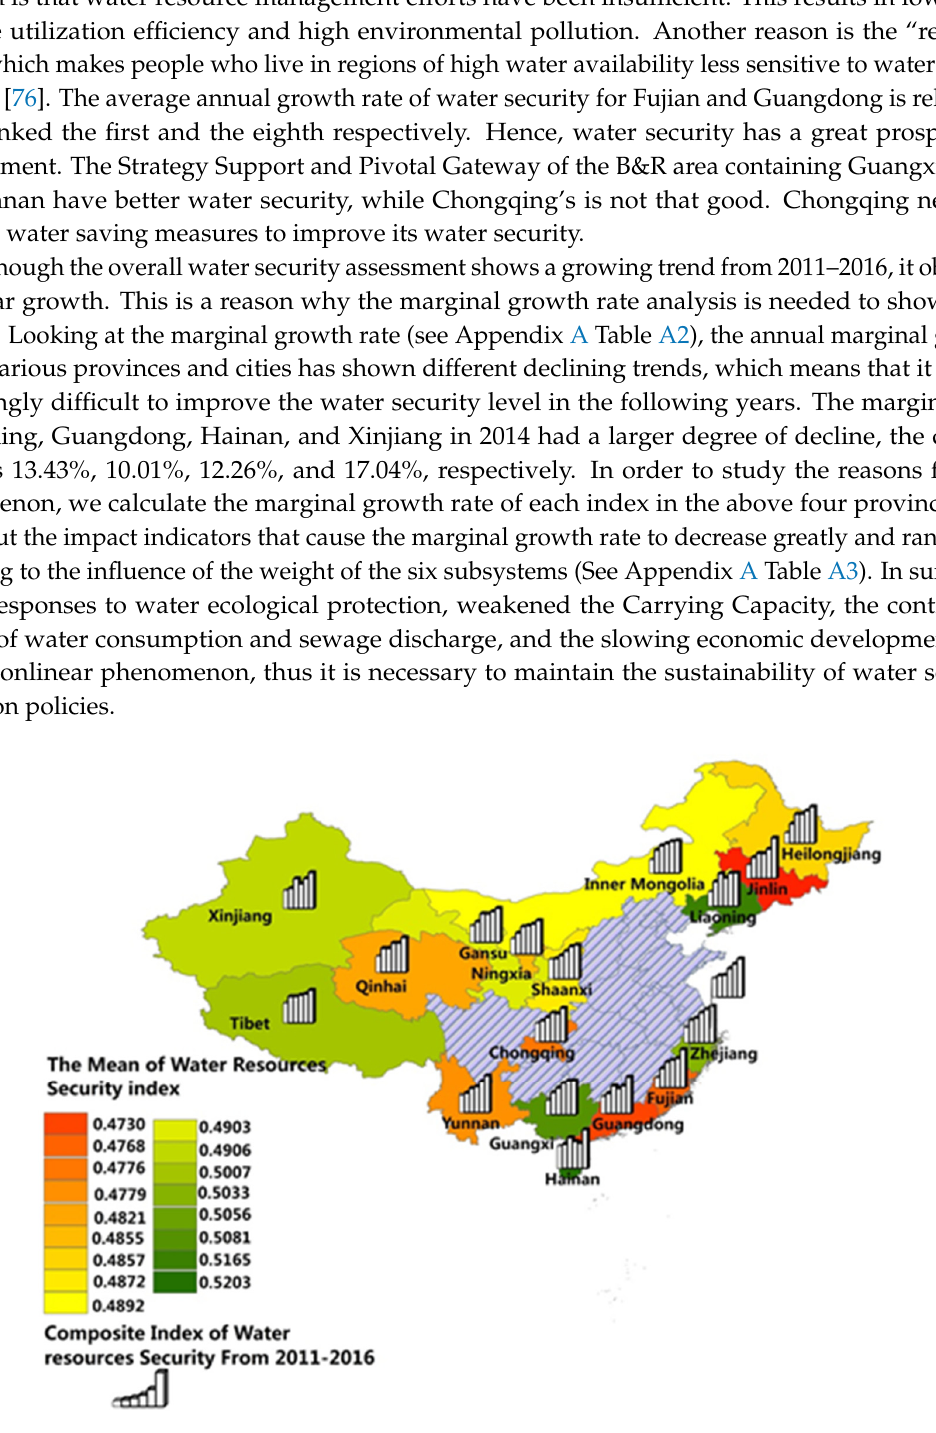
Figure 3. Water security level of the One Belt and One Road region in China.